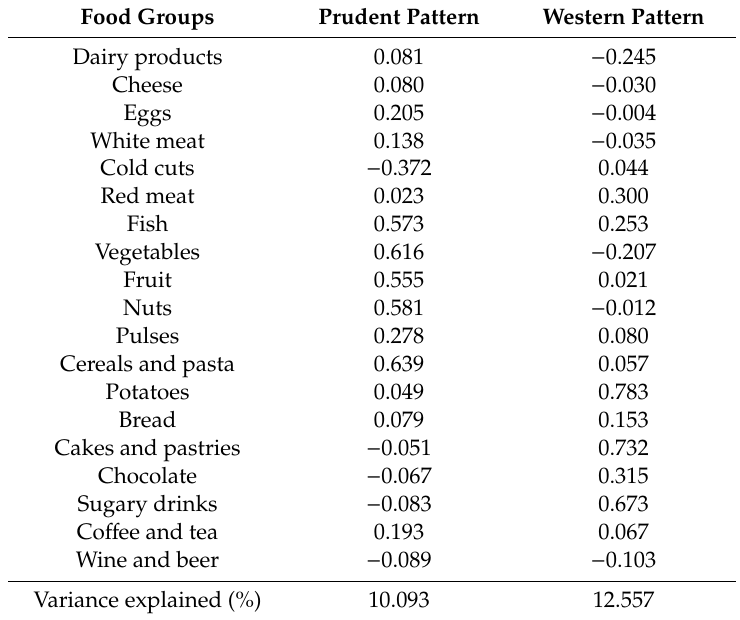
Table 2. Factor loadings for the di ff erent food groups for each dietary pattern ( N =